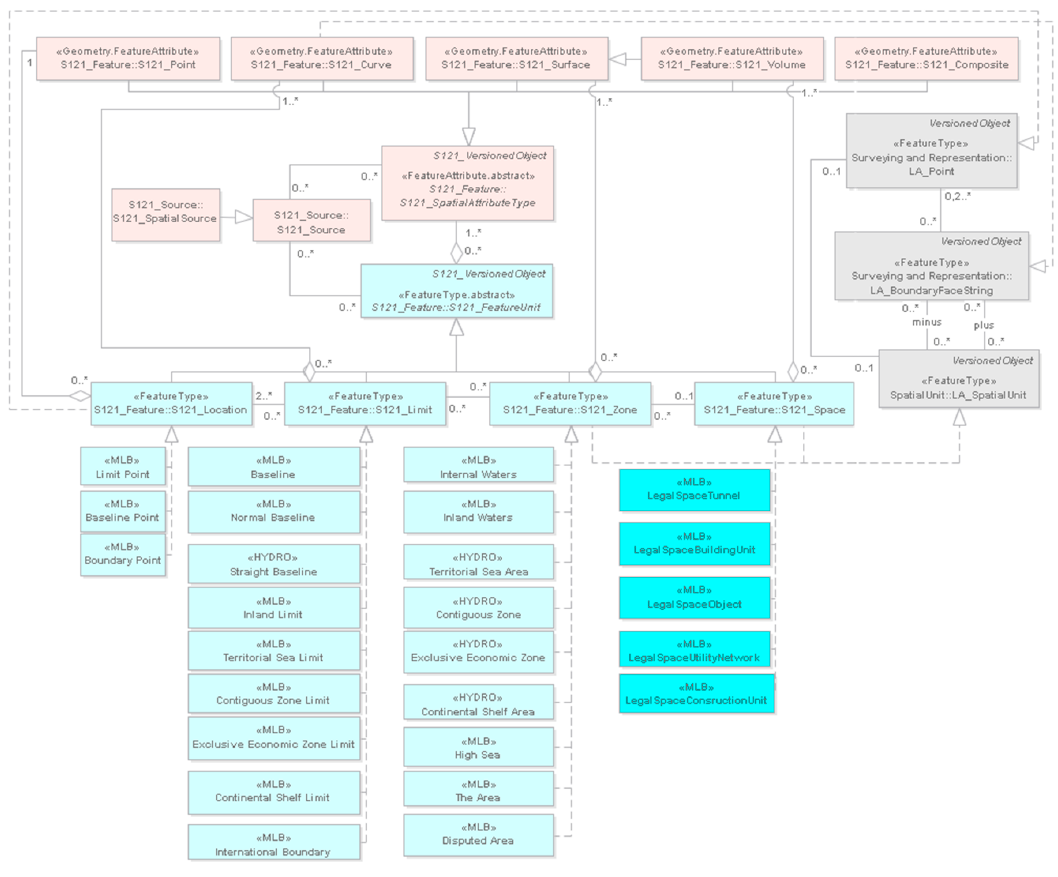
Figure 7. S-121 Spatial Unit package ([18], p. 68, edited).